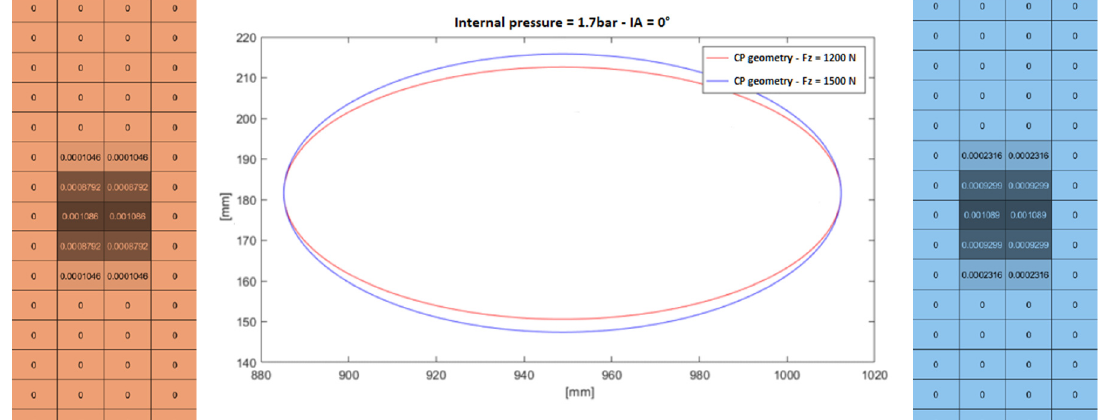
Figure 3. Example of thermoRIDE contact patch geometry representation.